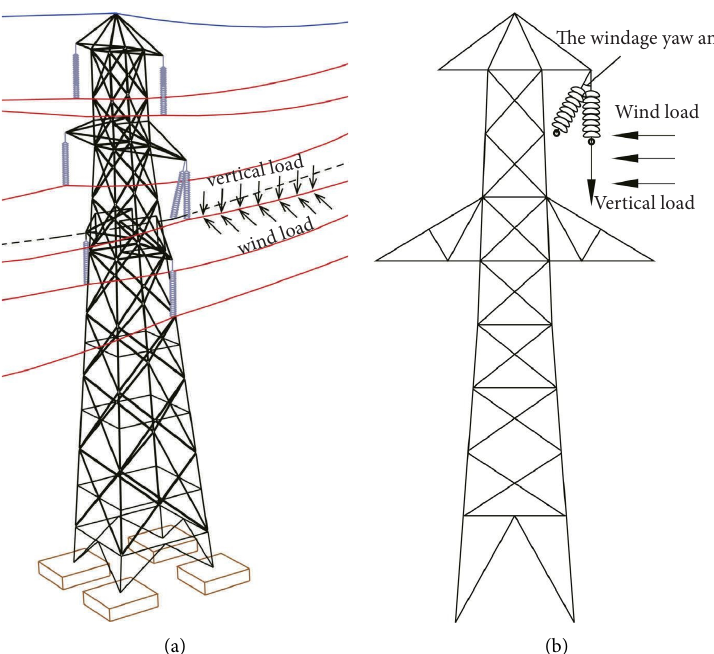
Figure 1: (a) Te windage yaw model of the transmission tower insulator string. (b) Te simplifed calculation model of the windage yaw